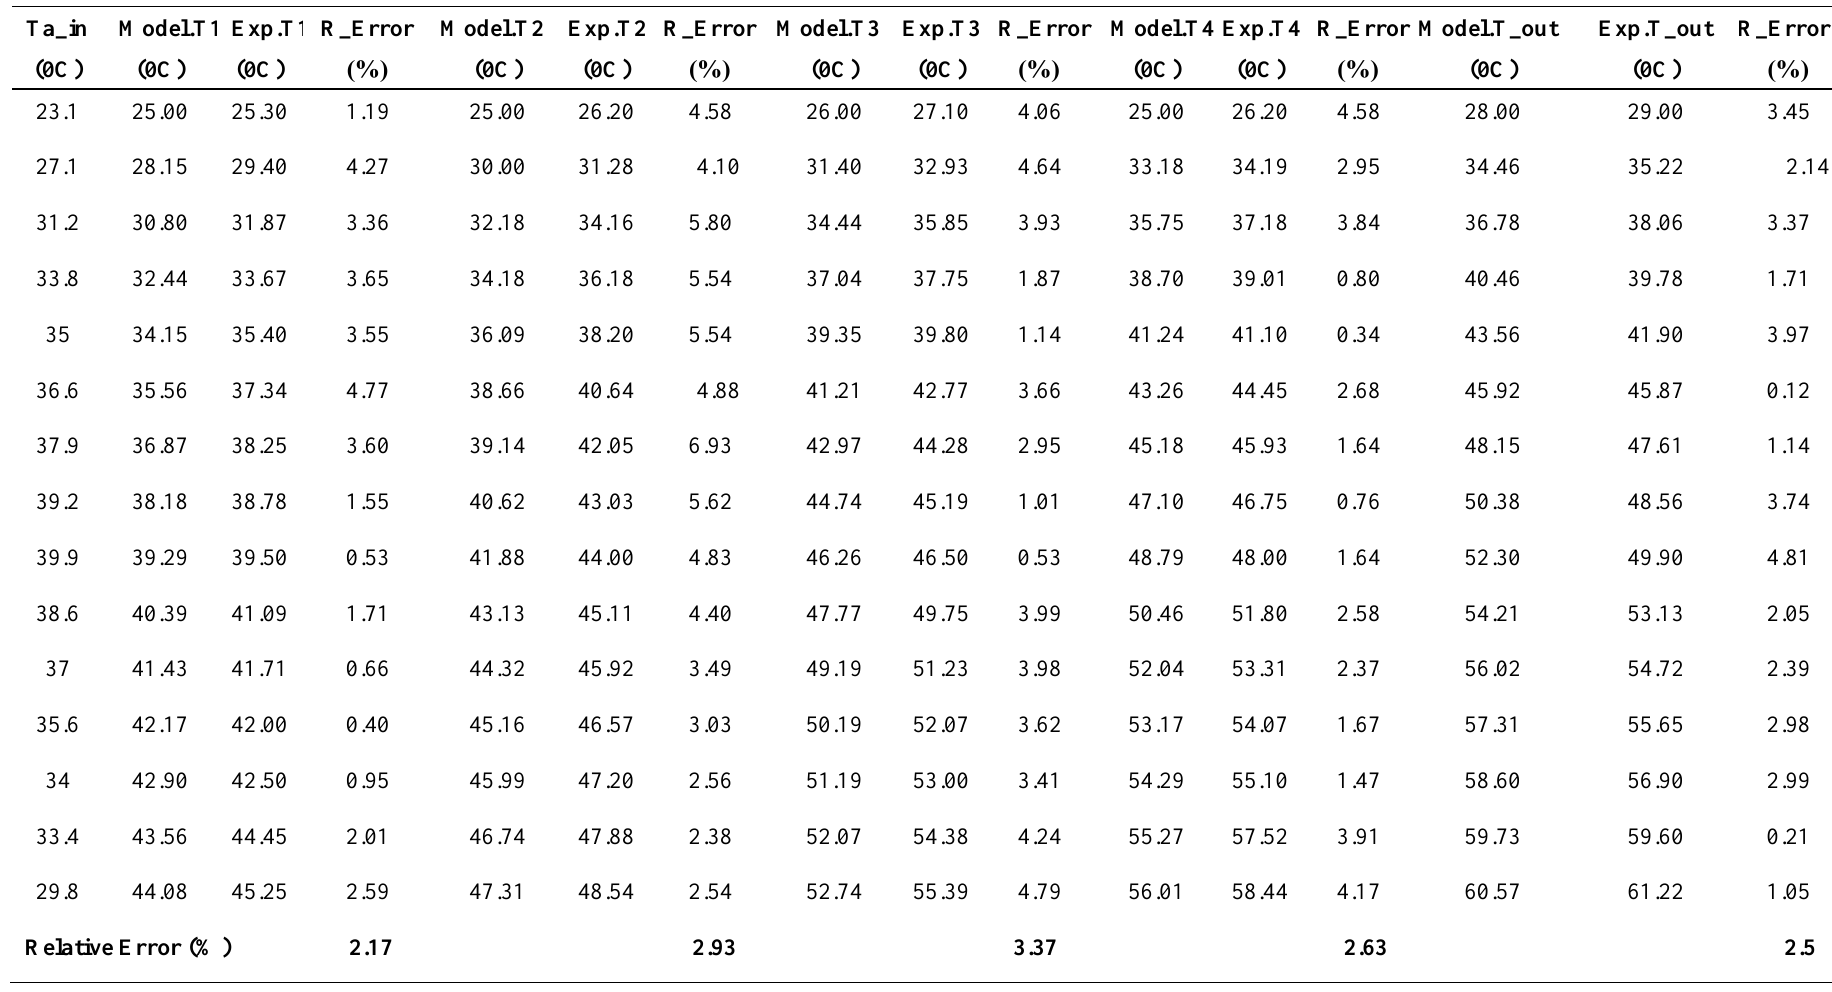
Table 2. Results of model validation for solar air heater average temperature compared with the results in [23].